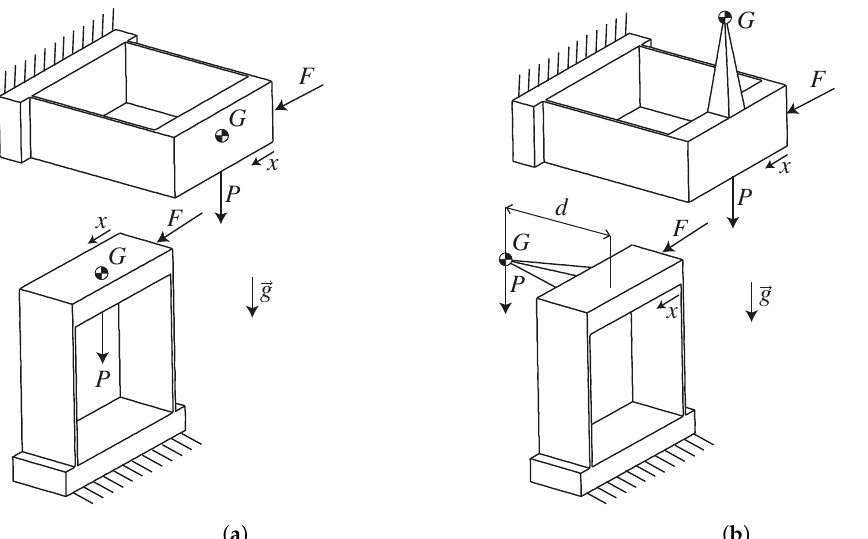
Figure 8. Illustration of the effect of offsetting a flexure mechanism’s COM from its plane of motion. When offsetting the COM ( b ), the gravity load in vertical position induces an out-of-plane bending moment P · d in the flexures that is not present when the COM is in the plane of motion ( a ). This, however, does not change the loading condition of the flexures in horizontal position so the parameter d can be used to make the effects in vertical and horizontal positions